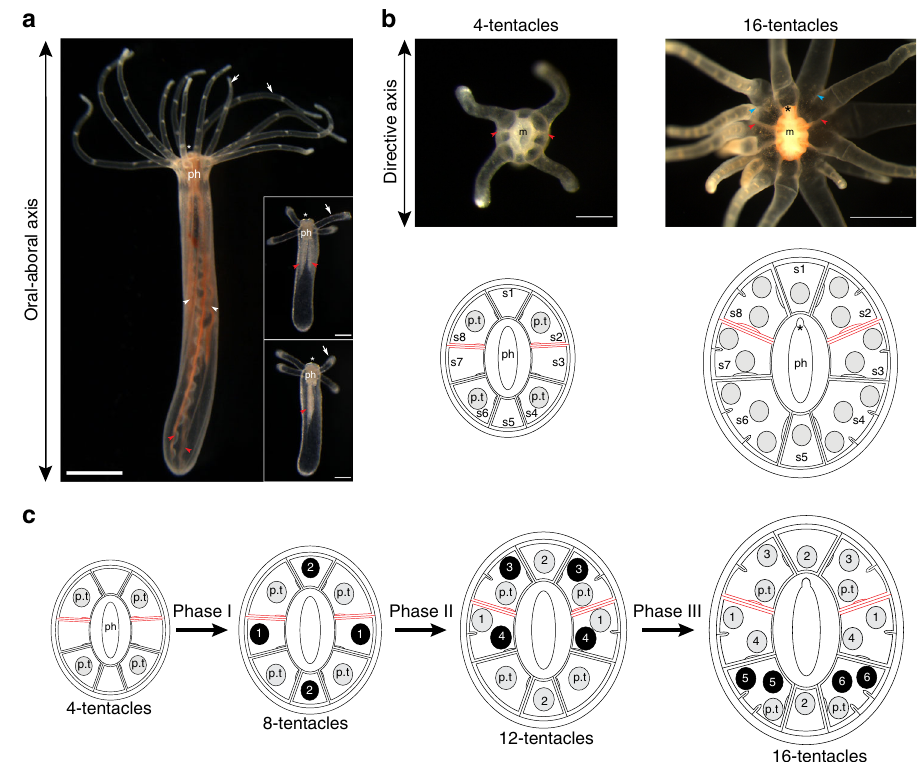
Fig. 1 Body axes and tentacle arrangement in primary and adult polyps. a Lateral views of an adult polyp bearing 12 tentacles (left panel, n = 14 polyps) and a 4-tentacle primary polyp (right panels, n = 20 polyps). Animals were pictured live in three independent experiments. White asterisk (*) indicates the position of the oral pole. The pharynx (ph) is attached to the body wall through eight endodermal mesenteries. Right panels show 90° rotation of a four- tentacle polyp. Two primary mesenteries (red arrowheads ) form a mirror image along the directive axis. In adults, these primary mesenteries maintain a growth advantage over the remaining mesenteries (white arrowheads). Note that the position of primary mesenteries can serve as a landmark to orient the oral pole along the directive axis. White arrows show tentacles. Scale bars are 1 mm and 100 μ m in left and right panels, respectively. b Oral views of 4- tentacle and 16-tentacle polyps ( n = 131 primary polyps, n = 108 adult polyps, three independent experiments). Both oral poles show eight segments and are oriented along the directive axis using the position of primary mesenteries (red arrowheads ) . Black asterisk (*) indicates the position of the siphonoglyph at one end of the mouth (m). Blue arrowheads indicate two examples of boundaries between neighboring tentacles within segments. Scale bars are 250 μ m and 1 mm in left and right panels, respectively. Lower panels: diagrammatic cross-section through the oral pole summarizes the arrangement of tentacles. The eight body segments are annotated from segment 1 (s1) to segment 8 (s8). Primary mesenteries are colored in red. Tentacles are depicted as gray discs. Primary tentacles (p.t) resulting from embryonic development are indicated. c Summary of the representative pattern of tentacle addition showing the three phases. The sequence of budding events is indicated as black discs with a